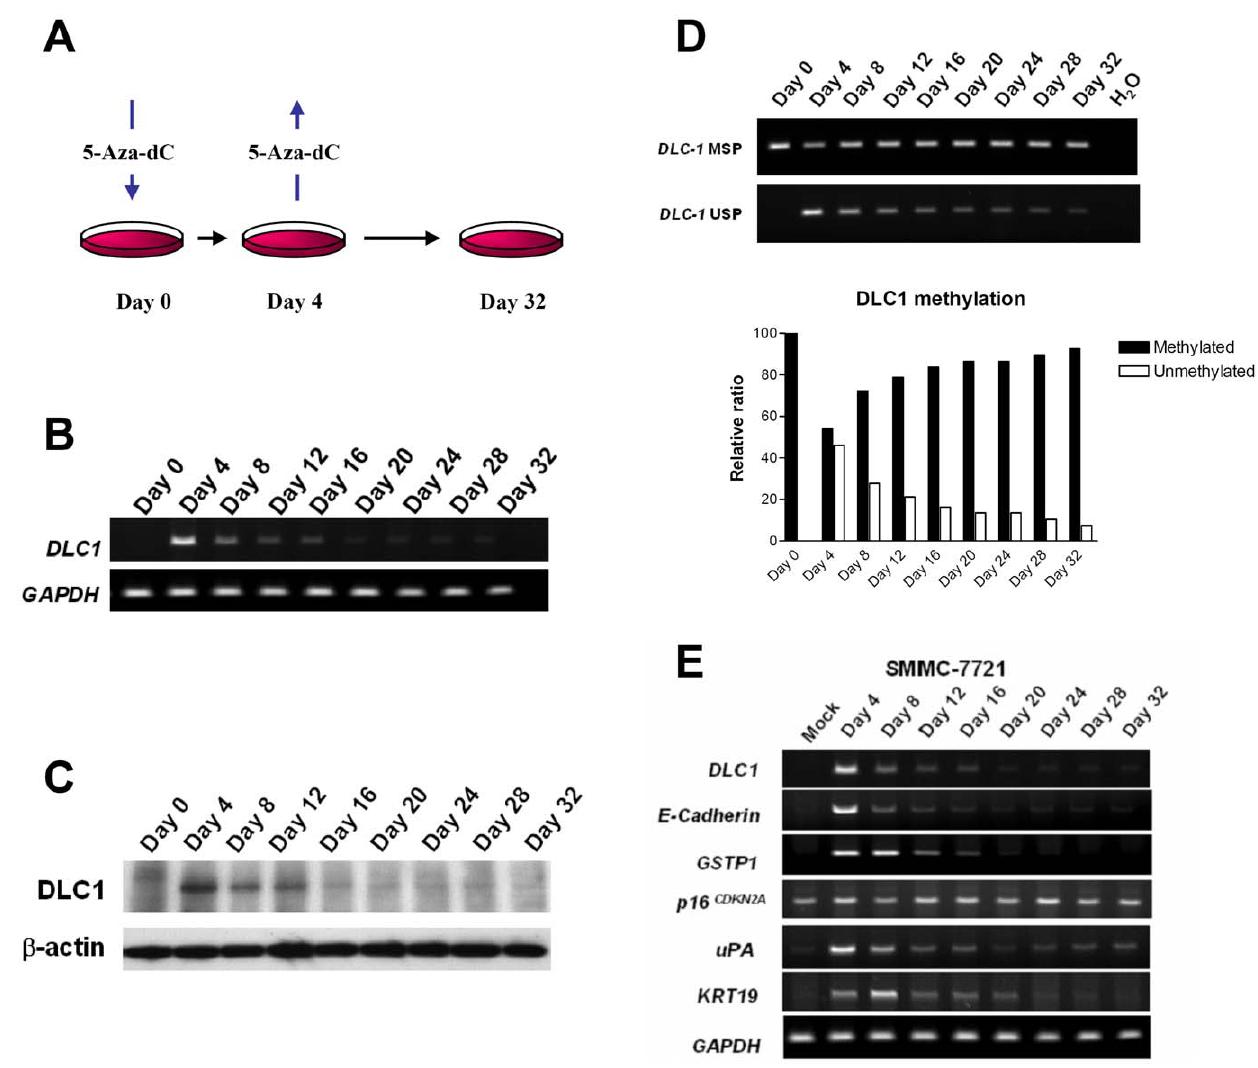
Figure 1. DNA re-methylation after 5-Aza-dC treatment. (A) Schematic outline of the experimental design. SMMC-7721 cells were treated with 5-Aza-dC at 10 m M for 4 days to induce global demethylation. At Day 4, 5-Aza-dC was removed and cells were replenished with normal culture medium (DMEM-high glucose, supplemented with 10% FBS). 5-Aza-dC treated cells were allowed to recover in the absence of 5-Aza-dC for an additional 4 weeks. DLC1 mRNA (B) and protein (C) expression in SMMC-7721 was gradually re-silenced when released from 5-Aza-dC treatment